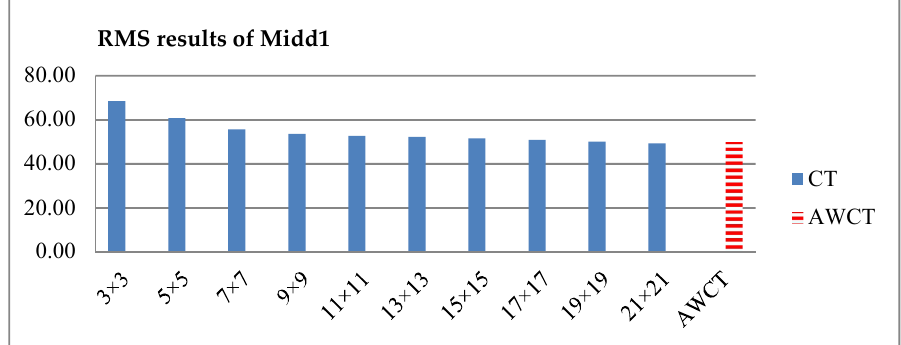
Figure 19. RMS comparison results of Midd1 between AWCT and CT.